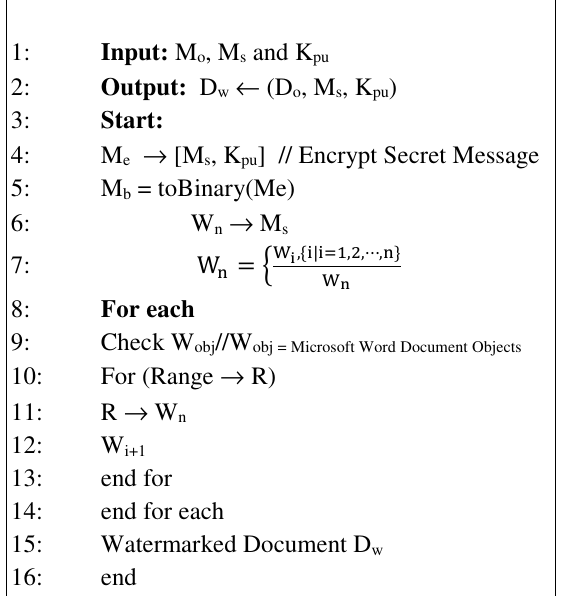
The Algorithm1: First Level Watermark Embedding